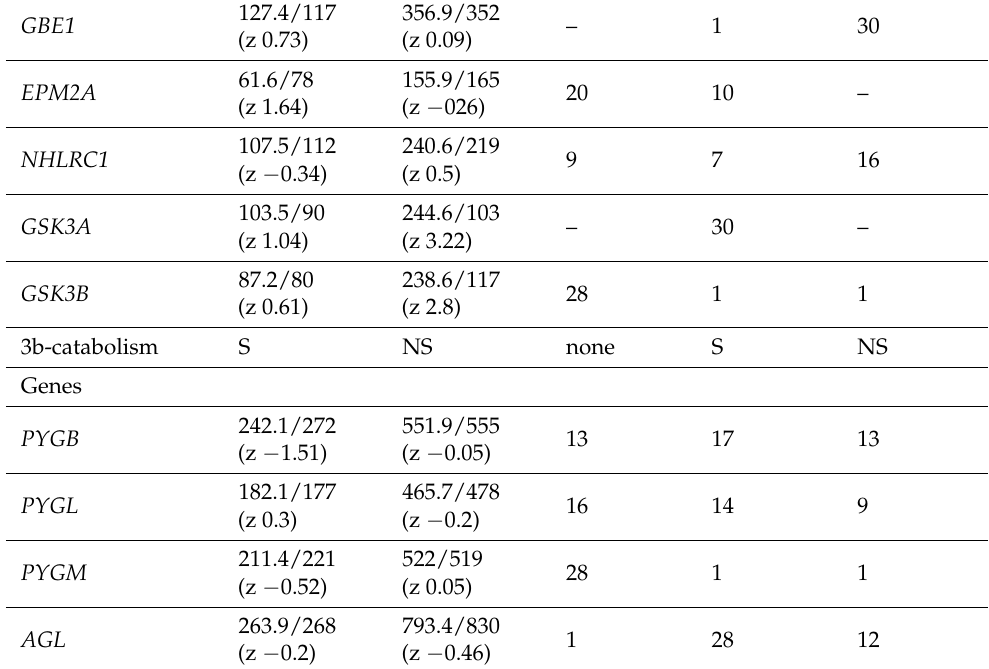
Table 4. a : Exonic variants found in genes acting on glycogen synthesis. The incidence in the popula- tion (gnomAD) and in the sample studied was compared using Fisher’s exact test for count data due to the small sample size of observations for many of the alleles analyzed; differences were considered